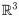
Geometric illustration of flat and nonlinear Galerkin projected dynamics in R3.3D manifold S living in (ξ1, ξ2, η1) is projected to 2D plane parametrized by (ξ1, ξ2). Parametrization is assumed to be imperfect, i.e. out-of-plane coordinate η1 cannot be uniquely determined from (ξ1, ξ2). Flat Galerkin method always uses the dynamics corresponding to η1 = 0. Nonlinear Galerkin method uses the dynamics corresponding to η1 = Φ(ξ1, ξ2) where Φ is determined by some prescribed criterion (e.g. minimization of L2 error).